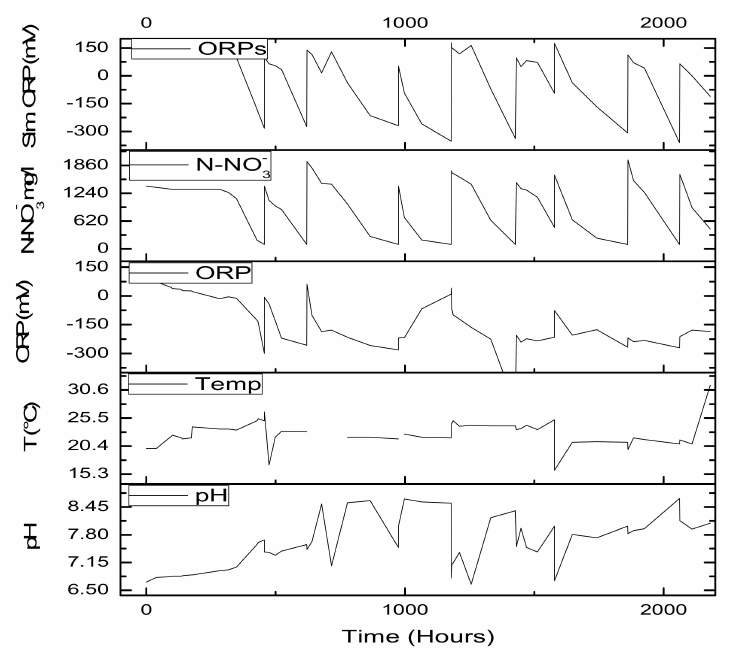
Figure 9. Parameters in the denitrification process with BRNW.